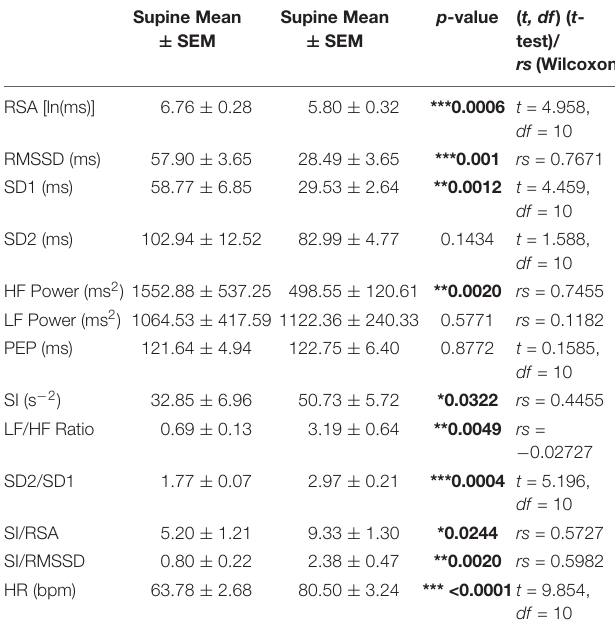
Number of subjects N = 11; t-value and df are reported when the t-test was applied while the rs (Spearman) value is reported where the non-parametric Wilcoxon signed rank test was applied. Abbreviations in this all and other tables: RSA, Respiratory Sinus Arrythmia; SI, Baevsky’s Stress Index or Sympathetic Index; RMSSD, Root Mean Square of Successive Differences; PEP, Pre-Ejection Period; HF, High Frequency; LF, Low Frequency; SD1, Standard deviation of minor axis of Poincare’ Plot; SD2, Standard deviation of major axis of Poincare’x Plot; HR, heart rate.